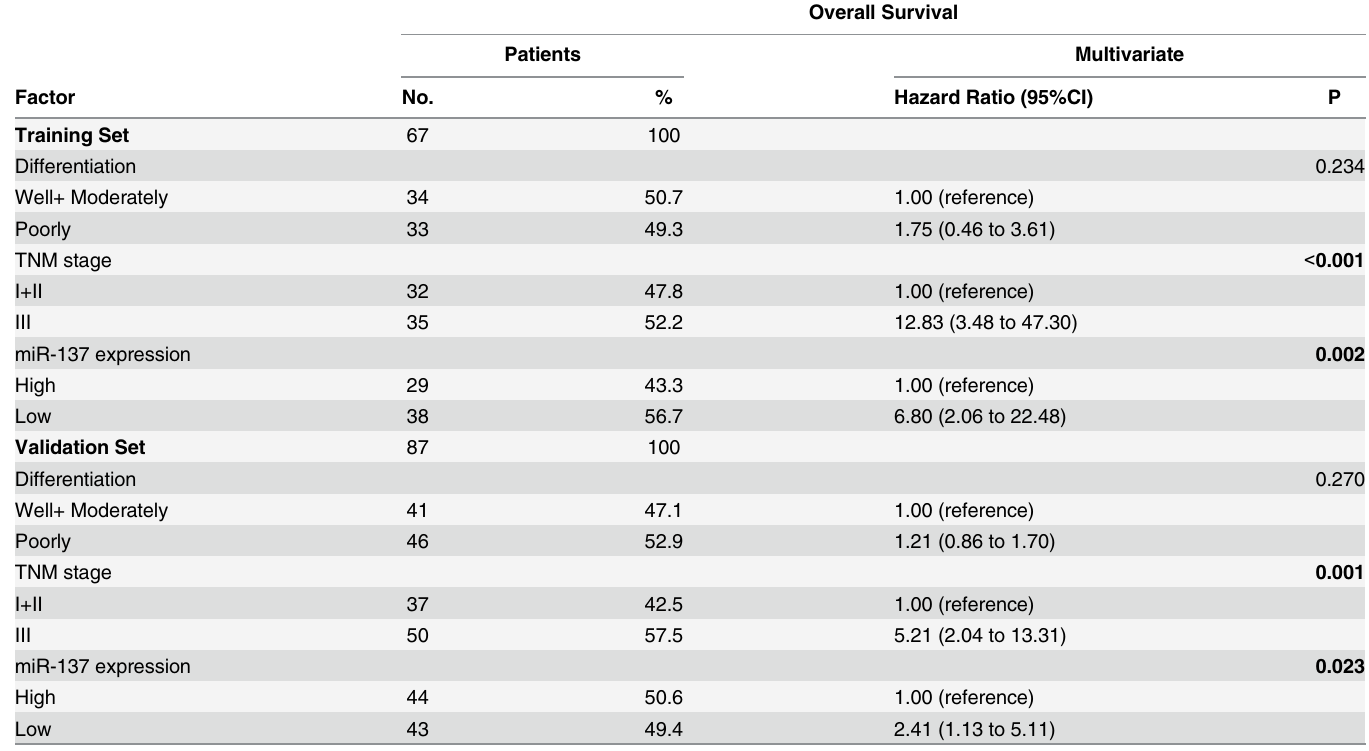
Table 3. Multivariate Cox Regression Analyses for Overall Survival.